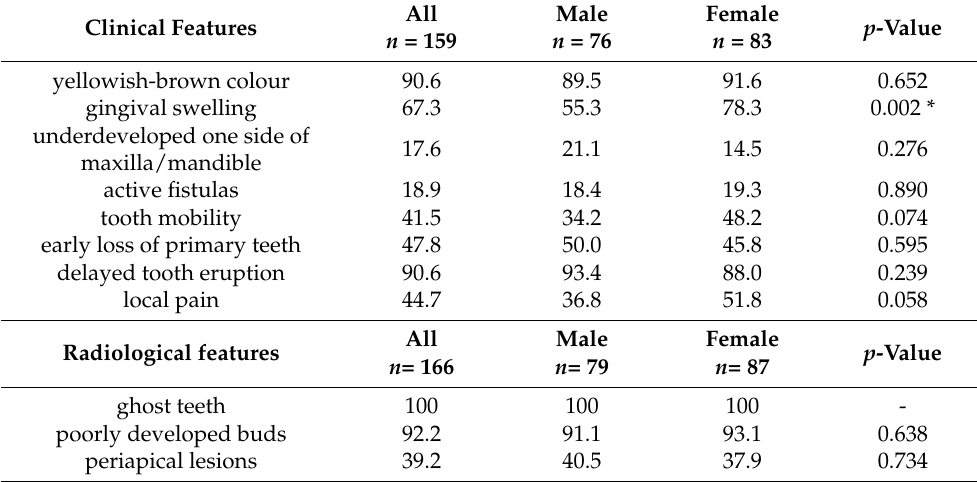
Table 3. Clinical and radiological features in patients with regional odontodysplasia (%). Clinical Features